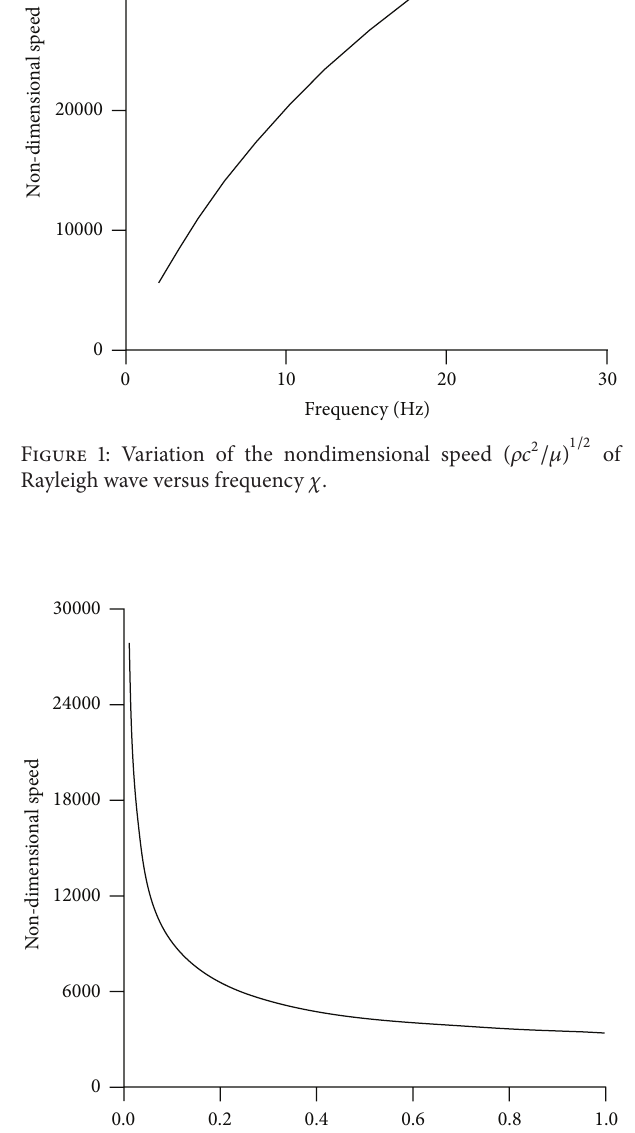
Figure 2: Variation of the nondimensional speed (𝜌𝑐 2 /𝜇) Rayleigh wave versus microtemperature constant 𝐾 2